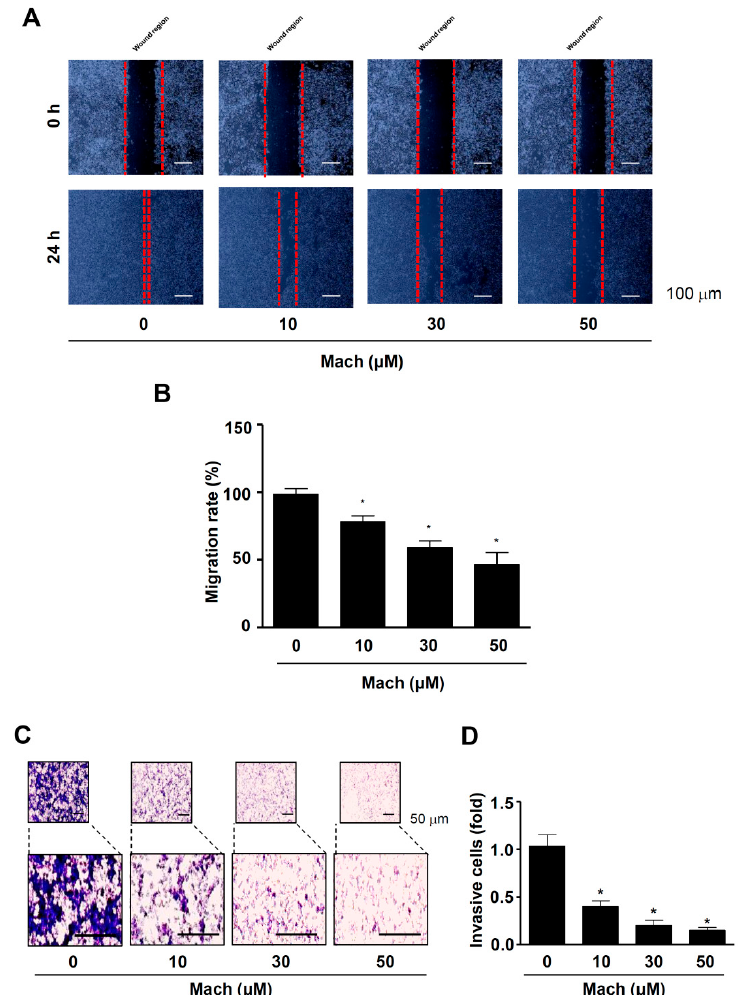
Figure 3. Effects of Mach on cell migration and invasion of human YD-10B OSCC cells. ( A , B ) Wound healing assay to assess cell migration. Migration was observed using a light microscope. Scale bar: 100 μ m ( A ). Relative migration (%) is shown as a bar graph ( B ). ( C , D ) Boyden chamber assay to assess cell invasion. Invasive cells were imaged using a light microscope. Scale bar: 50 μ m ( C ). Relative invasion is shown as a bar graph ( D ). Data are the mean ± SEM. Statistical significance was analyzed using Student’s unpaired t -test. Asterisks indicate statistical significance (* p < 0.05).